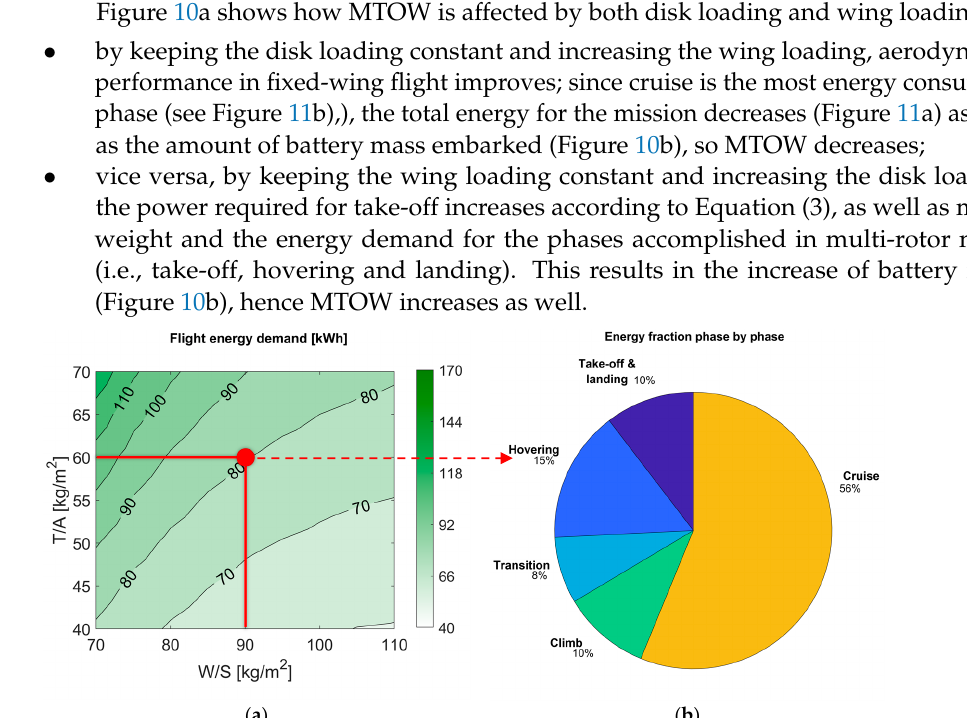
Figure 10. Wing loading ( W/S ) vs disk loading ( T/A ) charts (current technology level, range = 60 nm, speed = 50 m/s): ( a ) MTOW; ( b ) battery mass; ( c ) propeller clearance; ( d ) wingspan; ( e ) propeller diameter.